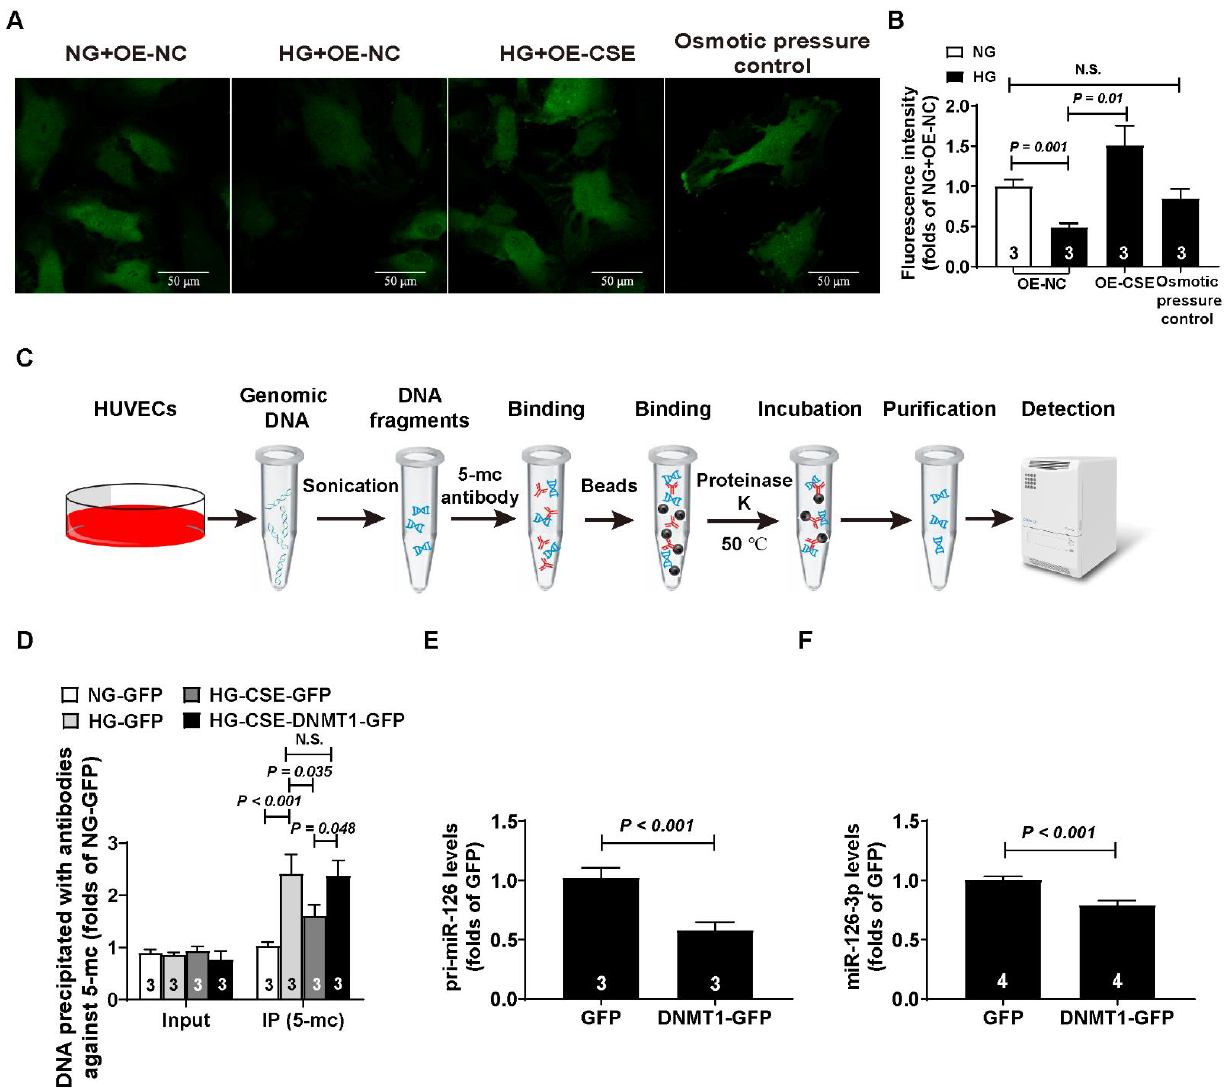
Figure 5. DNMT1 overexpression decreased pri-miR-126 and miR-126-3p levels in endothelial cells. ( A ) Representative micrographs showing the endogenous H 2 S in HUVECs with or without CSE overexpression under high-glucose conditions; bar = 50 μm. ( B ) Statistical analysis of fluorescence intensity of endogenous H 2 S; n = 3. ( C ) Schematic illustration of methylated DNA immunoprecipi- tation. ( D ) Statistical analysis of methylated DNA immunoprecipitation; n = 3. ( E ) pri-miR-126 levels in HUVECs with DNMT1 overexpression; n = 3. ( F ) miR-126-3p levels in HUVECs with DNMT1 overexpression; n = 4.